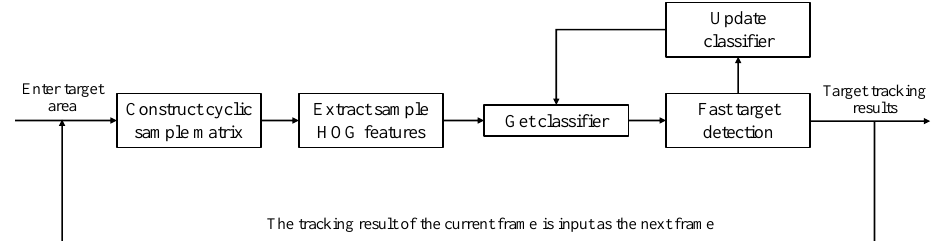
Figure 3. Overall flow of KCF tracking algorithm.